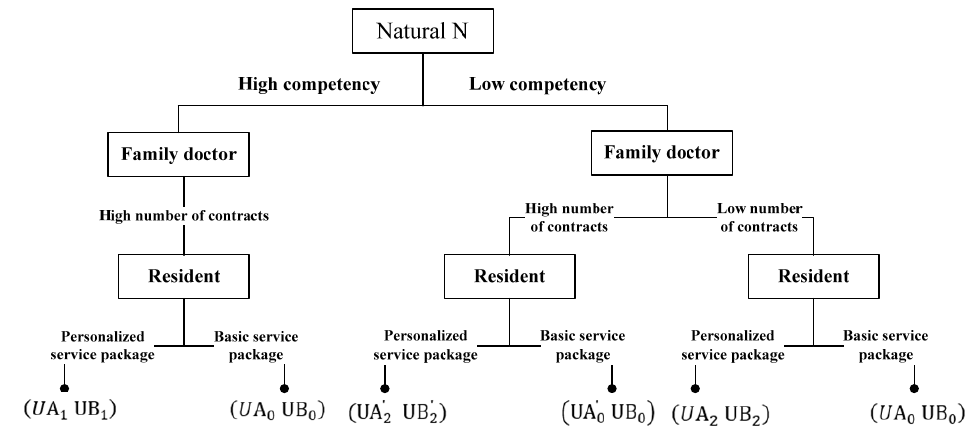
Figure 1. Signal game diagram of the family doctor contracted service.